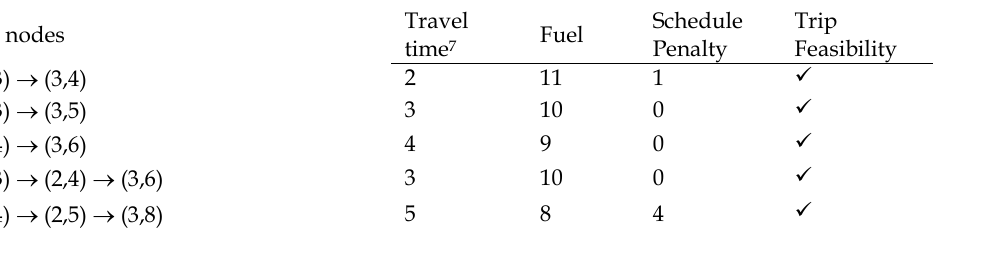
Pareto set for four-node example (with stops).